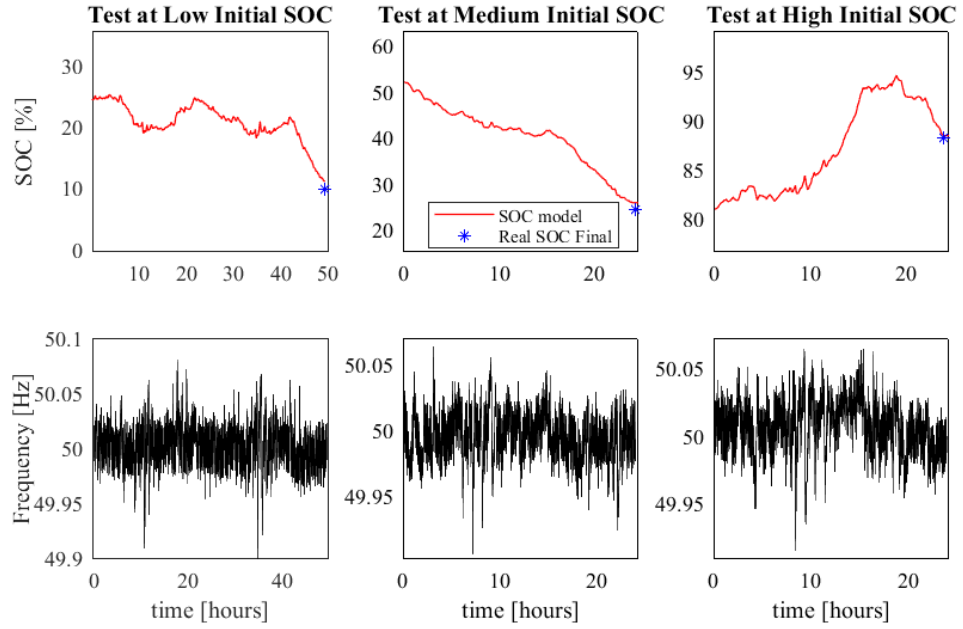
Figure 14. Figure 14. SOC estimation by model for primary frequency control (PFC) provision during validation tests. Table 10. Validation tests summary.